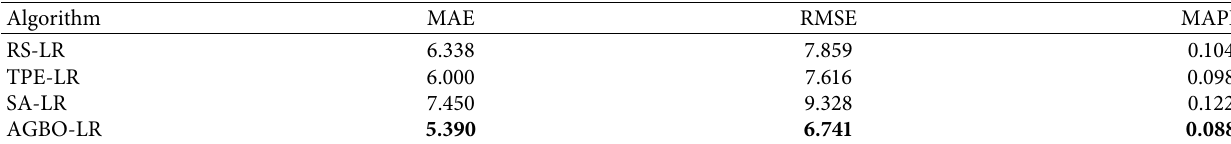
Table 3: The results of parameter identification with linear transformation.